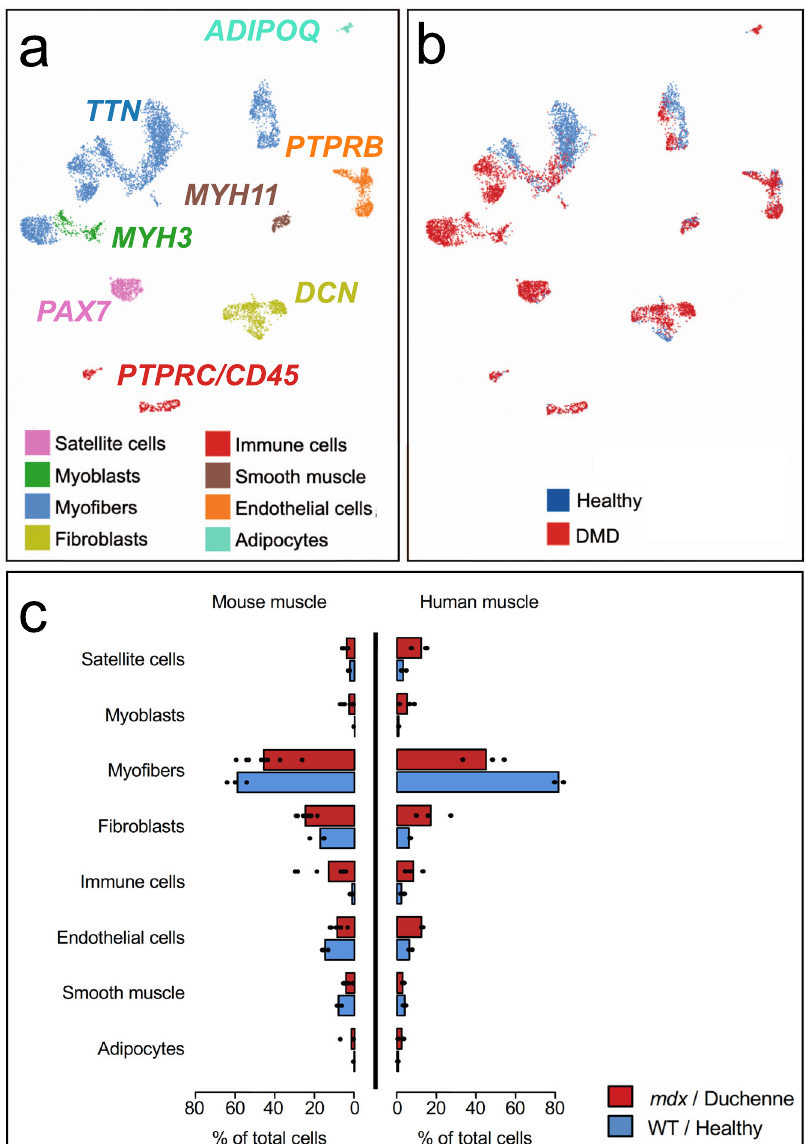
Fig. 7 Identi fi cation of cell populations in human vastus lateralis from healthy and DMD individuals using snRNAseq and comparison with mdx and WT mice. a Umap clustering of human VL single nuclei transcriptomes. Major cell types were labeled using canonical gene markers common to mouse and human, and labeled as indicated for each major cell type (see Supplementary Fig. 22 for all human cell subtypes and frequencies for healthy and DMD). Genes signi fi cantly associated with each cluster and subcluster were identi fi ed and reported in Supplementary Figs. 23 – 27, and Supplementary Data 9. b Individual nuclei are labeled as from a DMD (red) or healthy (blue) and plotted as per the U-map clusters identi fi ed in a to show disease-related expression shifts. c DMD ( n = 3) versus healthy ( n = 2) and mdx ( n = 8) versus WT ( n = 3) comparison of snRNAseq identi fi ed major cell-type proportions are highly concordant. Bar plots indicate mean percentage of total nuclei belonging to each major cell type, individual datapoint are shown as black dots. Raw data values are listed in Supplementary Data